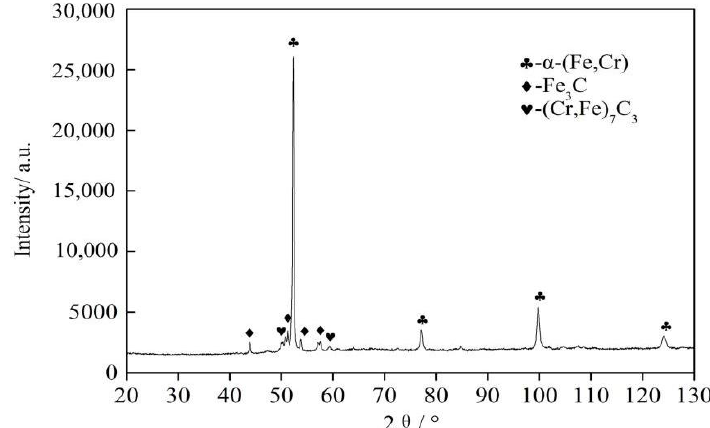
Figure 6. XRD result of Fe-based coating surface.